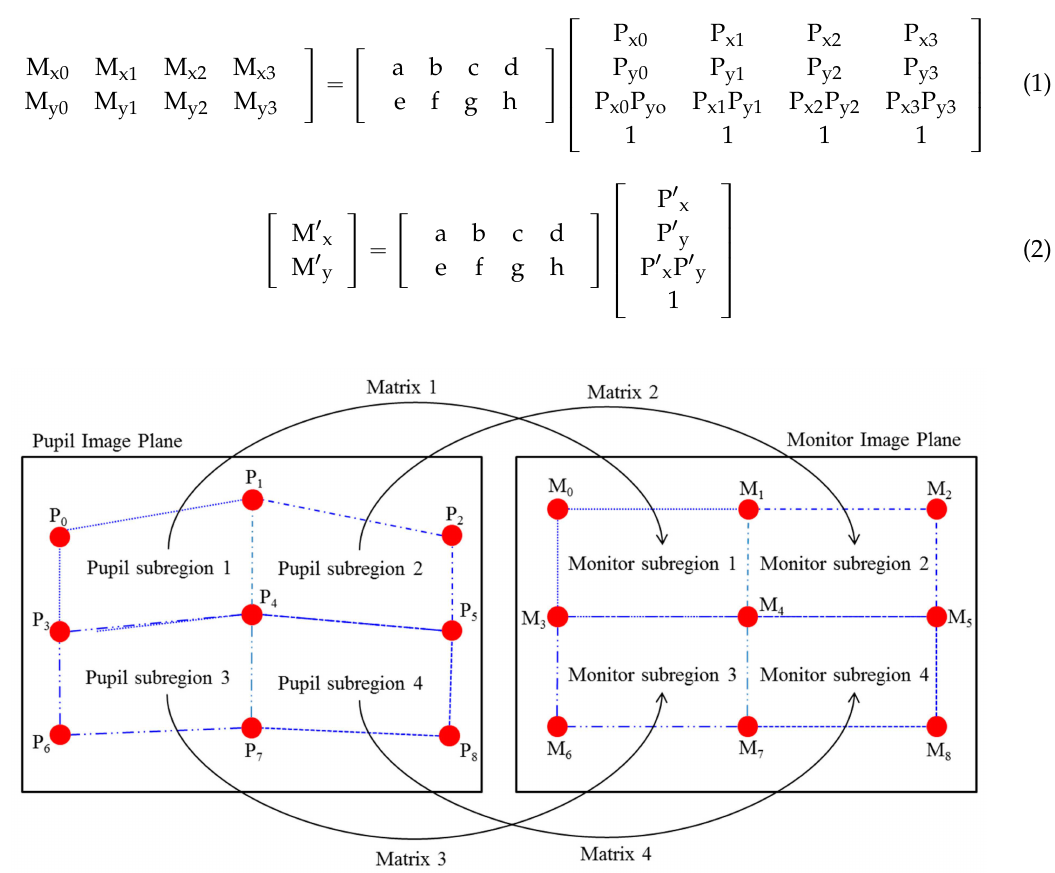
Figure 4. Corresponding relations of four subregions defined by nine pupil centers and four subregions in a monitor defined using calibration points.